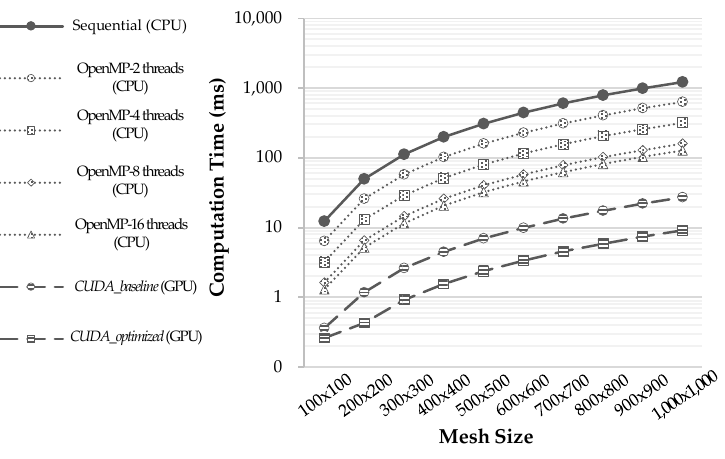
Figure 9. Average objective function computation time of sequential CPU, multi-threaded CPU, and parallel GPU